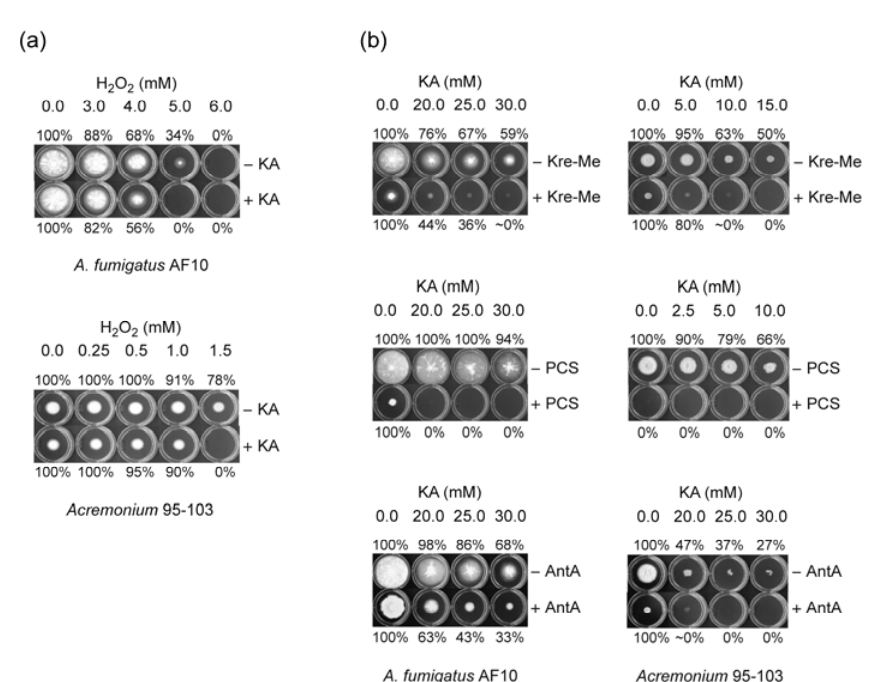
Figure 3. Exemplary agar (PDA) bioassays showing KA-mediated chemosensitization with ( a ) H O or ( b ) complex III inhibitors, tested against A. fumigatus AF10 or 2 2